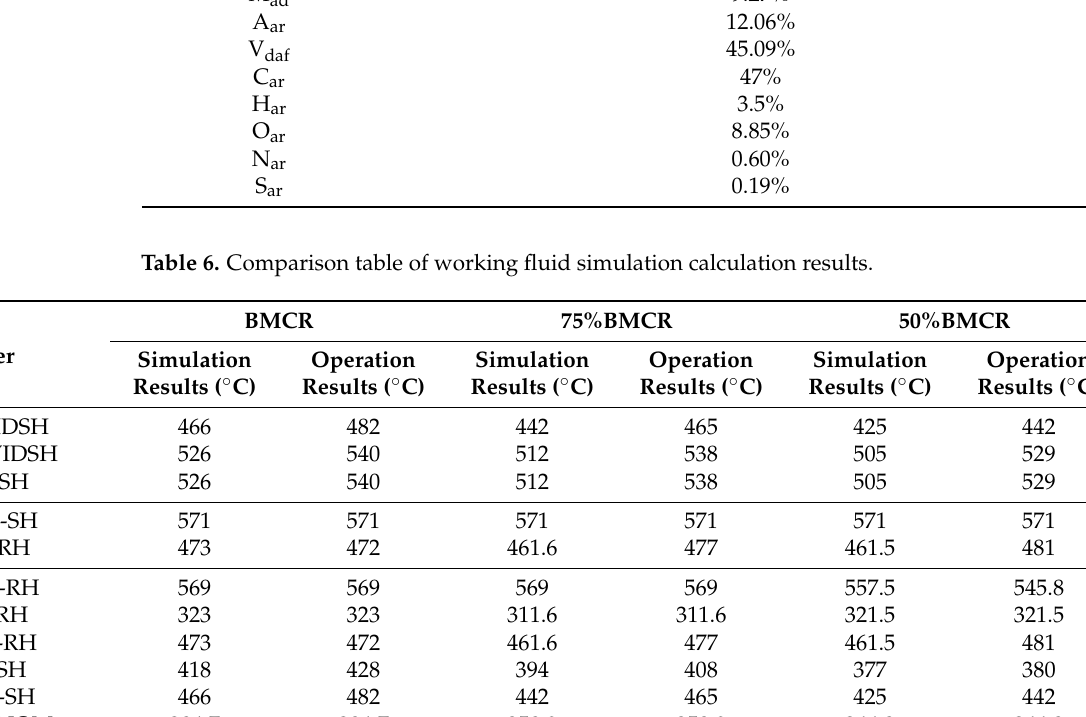
Table 6. Comparison table of working fluid simulation calculation results.